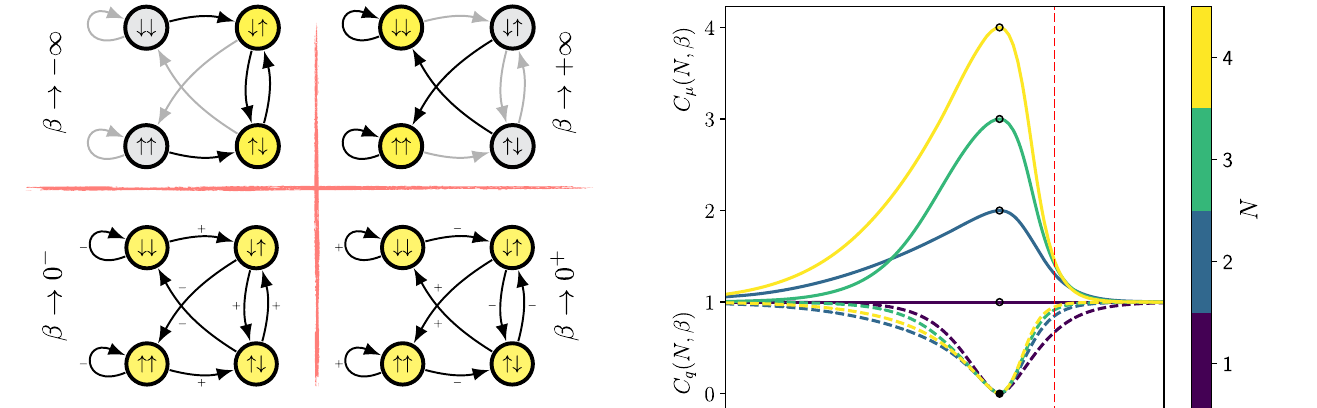
FIG. 10. Classical generators of four important rare classes. Top left: Negative infinite temperature limit. Top right: Positive temperature limit. Bottom left: Negative zero-temperature limit. Bottom right: Positive zero temperature limit. Gray edges and states denote them being rarely visited.